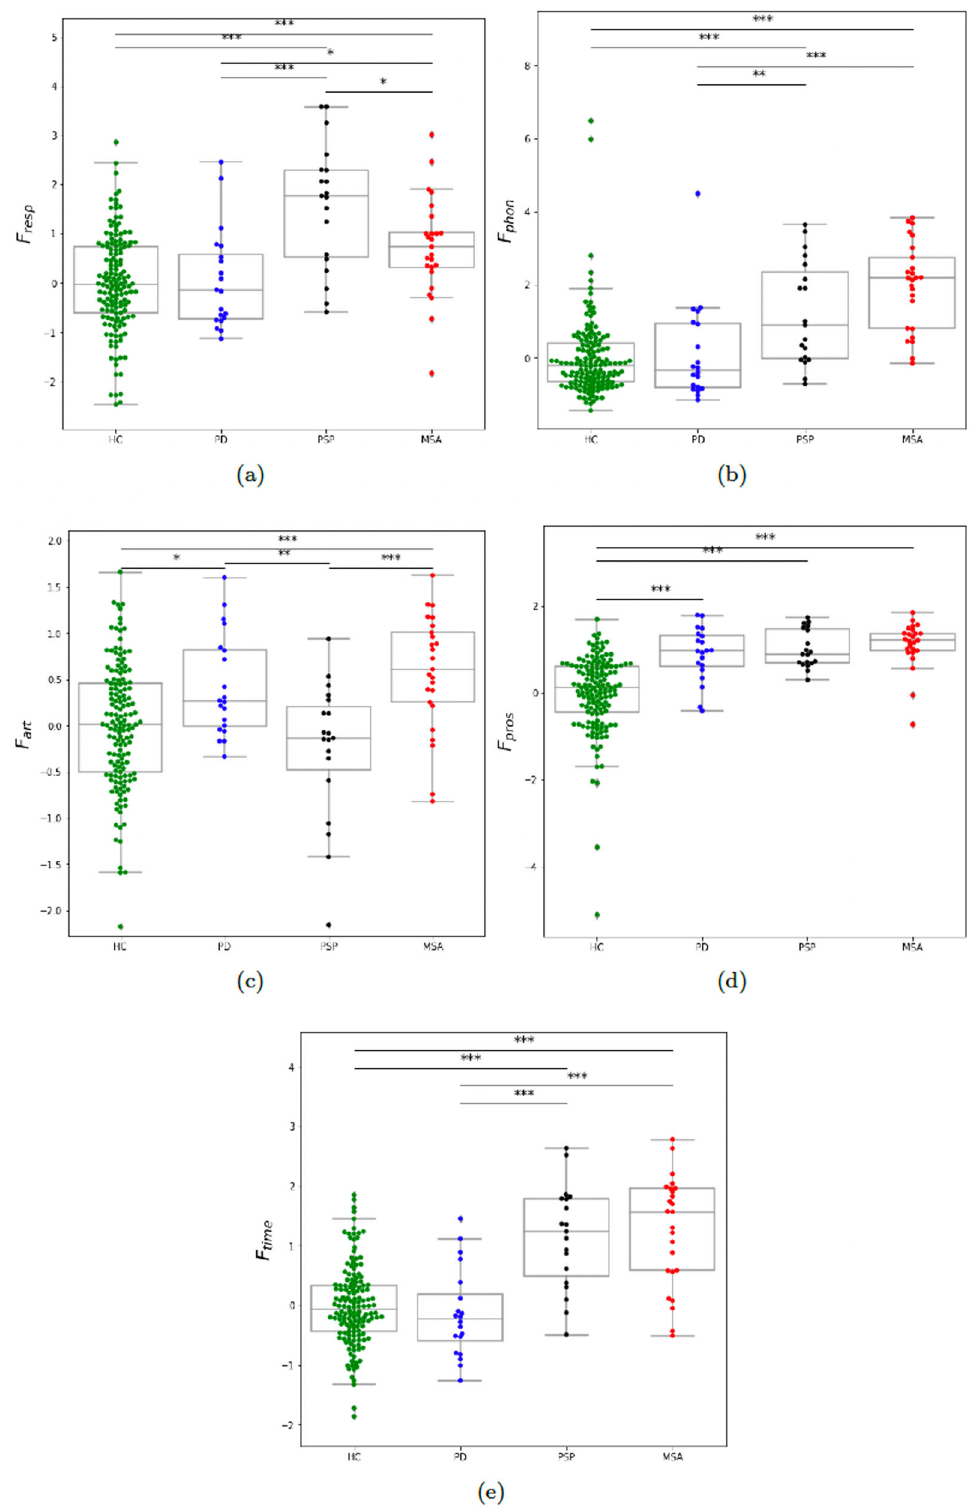
Fig. 2 Boxpolts of the distribution across groups of subsystem features. a F resp = respiration feature; b F phon = phonation feature; c F art = articulation feature; d F pros = prosodic feature; e F time = timing feature. HC healthy controls, PD Parkinson ’ s disease, MSA multiple system atrophy, PSP progressive supranuclear palsy. Statistically signi fi cant differences between groups: * p < 0.05, ** p < 0.01, *** p <